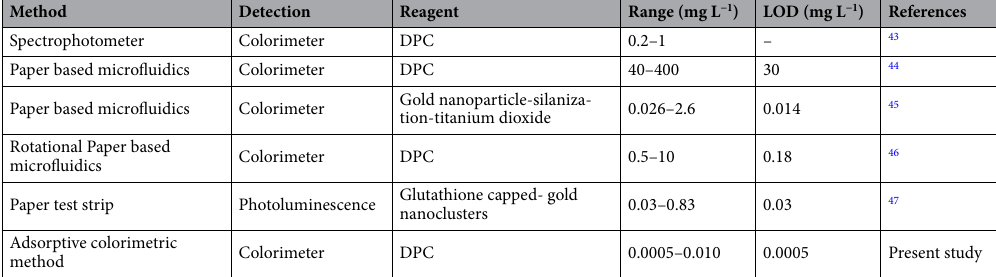
Table 2. Comparison of existing methods with adsorptive colorimetric method for the detection of Cr(VI) ions.